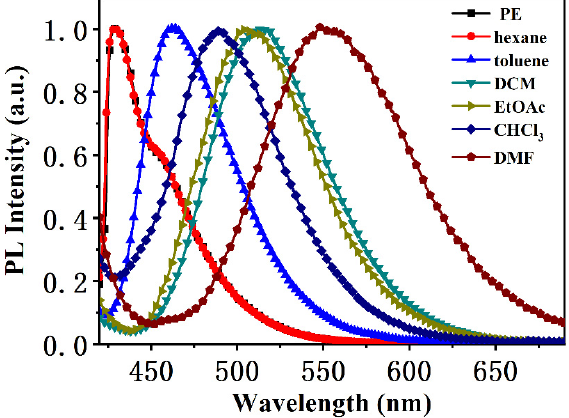
Figure 4. Normalized UV-vis absorption spectra of PY-C16 in different solvents.